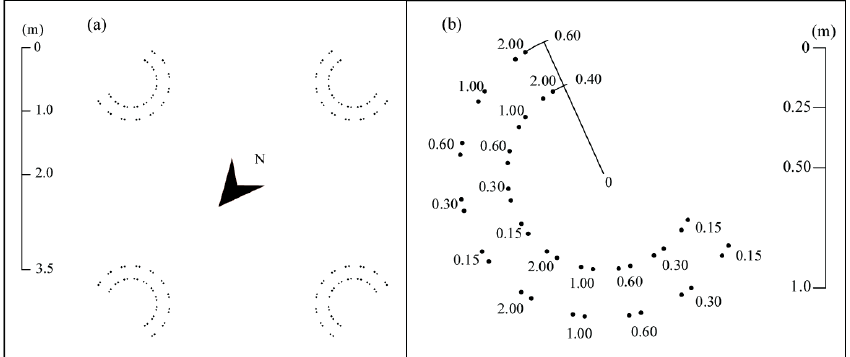
Figure 2. Grugliasco site. ( a ) Layout of the TDR probes in the experimental field; and ( b ) detail of the disposition of the probes of different lengths within one of the four groups.